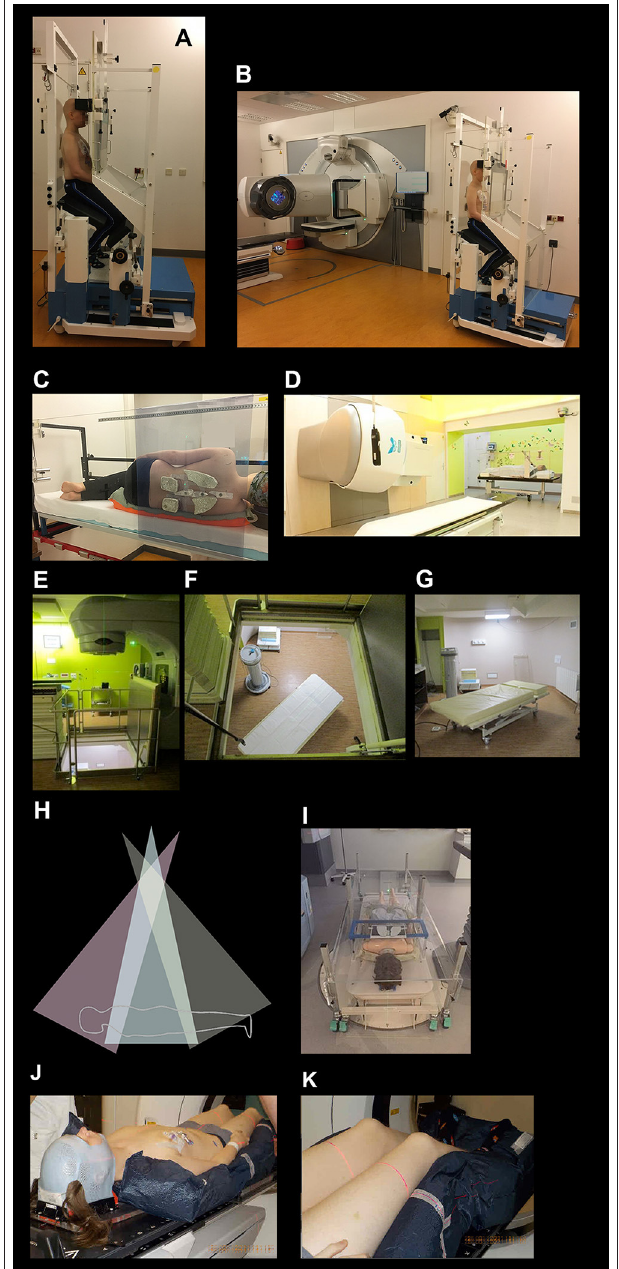
FIGURE 1 | Total body irradiation setup examples. (A,B) A patient in an institution-developed TBI “chair” setup for opposed anterior/posterior (AP-PA) dose delivery with acrylic beam spoilers in front of and behind the patient; the chair is rotated 180 ◦ halfway through each fraction; shielding of lungs, kidneys, and lenses is performed with individually moulded cerrobend blocks. (C) A patient in an institution-developed TBI “bed” setup for AP-PA dose delivery in the lateral decubitus position, with beam spoilers; the patient is rotated 180 ◦ halfway through each fraction; shielding of lungs, kidneys, and lenses is performed with individually moulded cerrobend blocks. (D) A patient in an institution-developed TBI “bed” setup for lateral dose delivery in the supine position, with beam spoilers; the bed is rotated 180 ◦ halfway through each fraction and there is shielding of lungs. (E–G) An institution-developed TBI